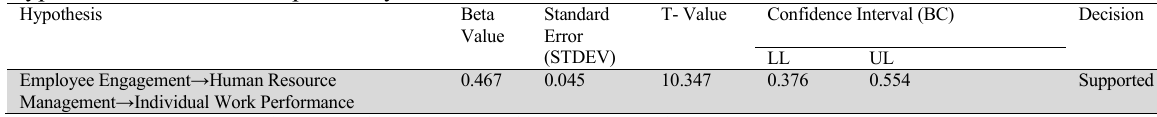
T- Standard Value Error (STDEV)